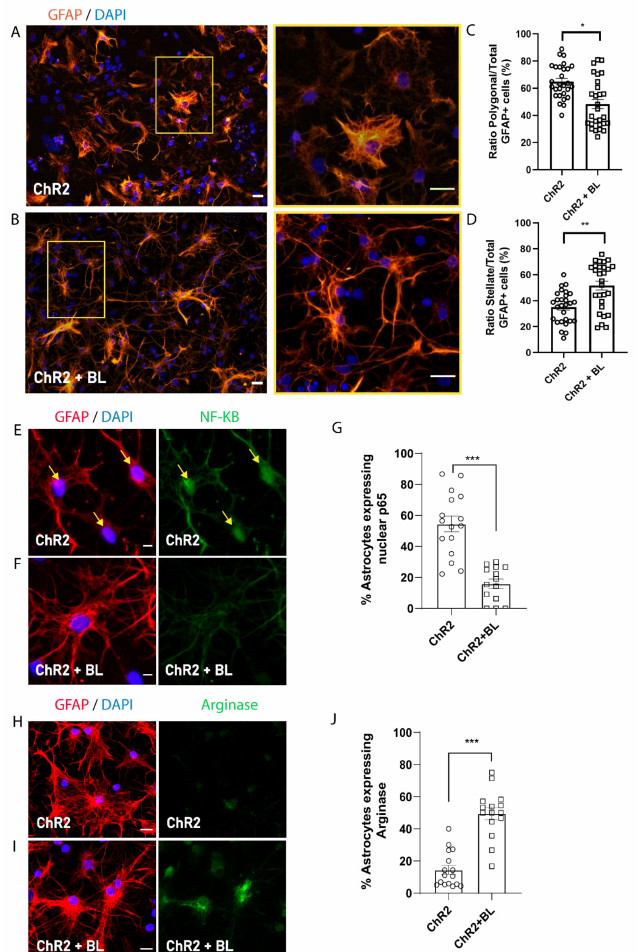
Figure 4. Optogenetic stimulation triggers morphological and functional shift in ChR2-NPC-derived astrocytes. Astrocyte morphology was determined after GFAP staining. ( A ) Representative images of immunofluorescence staining for GFAP (orange) and nuclear detection by 4 (cid:48) ,6-diamidino-2-phenylindole (DAPI) (blue) in unstimulated ChR2-NPCs (ChR2). Yellow square shows higher magnification for polygonal astrocytes. Scale bars, 20 µ M. ( B ) Representative images of immunofluores- cence staining for GFAP (orange) and nuclear detection by DAPI (blue) in BL-stimulated ChR2-NPCs (ChR2 + BL). Yellow square shows higher magnification for stellate astrocyte. Scale bars, 20 µ M. ( C ) Quantification of the ratio of polygonal astrocytes in unstimulated (ChR2) and BL-stimulated ChR2-NPCs (ChR2 + BL) cultures. Data are expressed as mean ± SEM from three independent experiments (ChR2: 64.9 ± 2.3; ChR2 + BL: 48.4 ± 3.4). * p < 0.05 vs. ChR2 determined by unpaired t -test. ( D ) Quantification of the ratio of stellate astrocytes in unstimulated (ChR2) and BL-stimulated ChR2-NPCs (ChR2 + BL) cultures. Data are expressed as mean ± SEM from three independent experiments (ChR2: 35.1 ± 2.3; ChR2 + BL: 51.6 ± 3.4). ** p < 0.01 vs. ChR2 determined by unpaired t -test. ( E ) Representative images of immunofluorescence staining for GFAP (red), nuclear factor-kappa B (NF-kB) (green), and nuclear detection by DAPI (blue) in unstimulated ChR2-NPCs (ChR2). Yellow arrows show nuclear staining. Scale bars, 10 µ M. ( F ) Representative images of immunofluorescence staining for GFAP (red), NF-kB (green), and nuclear detection by DAPI (blue) in BL-stimulated ChR2-NPCs (ChR2 + BL). Scale bars, 10 µ M. ( G ) Quantification of the percentage of astrocytes expressing nuclear NF-kB among unstimulated and BL-stimulated groups. Data are expressed as mean ± SEM from three independent experiments (ChR2: 54.5 ± 5.1; ChR2 + BL: 15.9 ± 3). *** p < 0.001 vs. ChR2 determined by unpaired t -test. ( H ) Representative images of immunofluorescence staining for GFAP (red), Arginase-1 (green), and nuclear detection by DAPI (blue) in unstimulated ChR2-NPCs (ChR2). Scale bars, 10 µ M. ( I ) Representative images of immunofluorescence staining for GFAP (red), Arginase-1 (green), and nuclear detection by DAPI (blue) in BL-stimulated ChR2-NPCs (ChR2 + BL). Scale bars, 10 µ M. ( J ) Quantification of the percentage of astrocytes expressing Arginase-1 among unstimulated and BL-stimulated groups. Data are expressed as mean ± SEM from three independent experiments (ChR2: 14.5 ± 2.8; ChR2 + BL: 49.6 ± 3.9). *** p < 0.001 vs. ChR2 determined by unpaired t